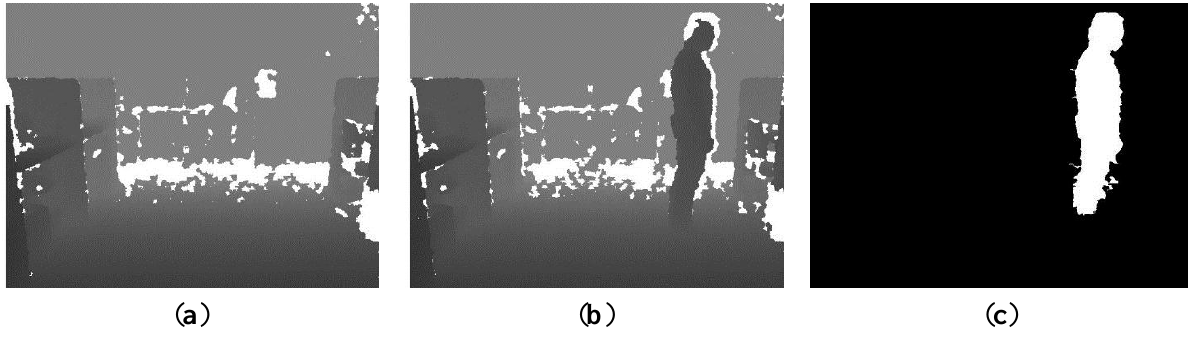
Figure 2. Extraction of human silhouette. ( a ) Background depth frame; ( b ) foreground depth frame; ( c ) extracted human silhouette.